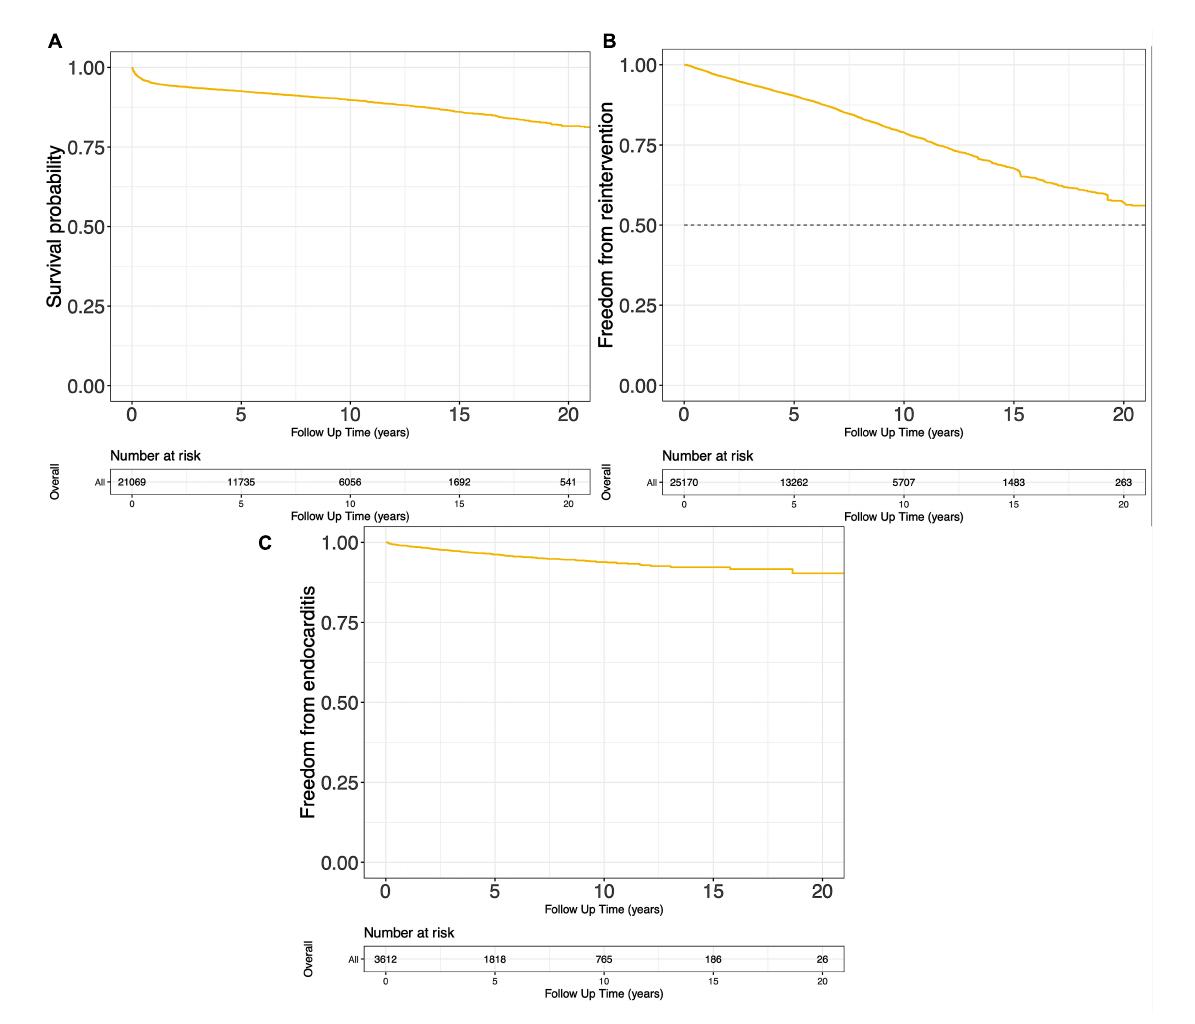
FIGURE3 Pooled Kaplan-Meier curves of freedom death (A) , freedom from reintervention (B) , and freedom from endocarditis (C) .